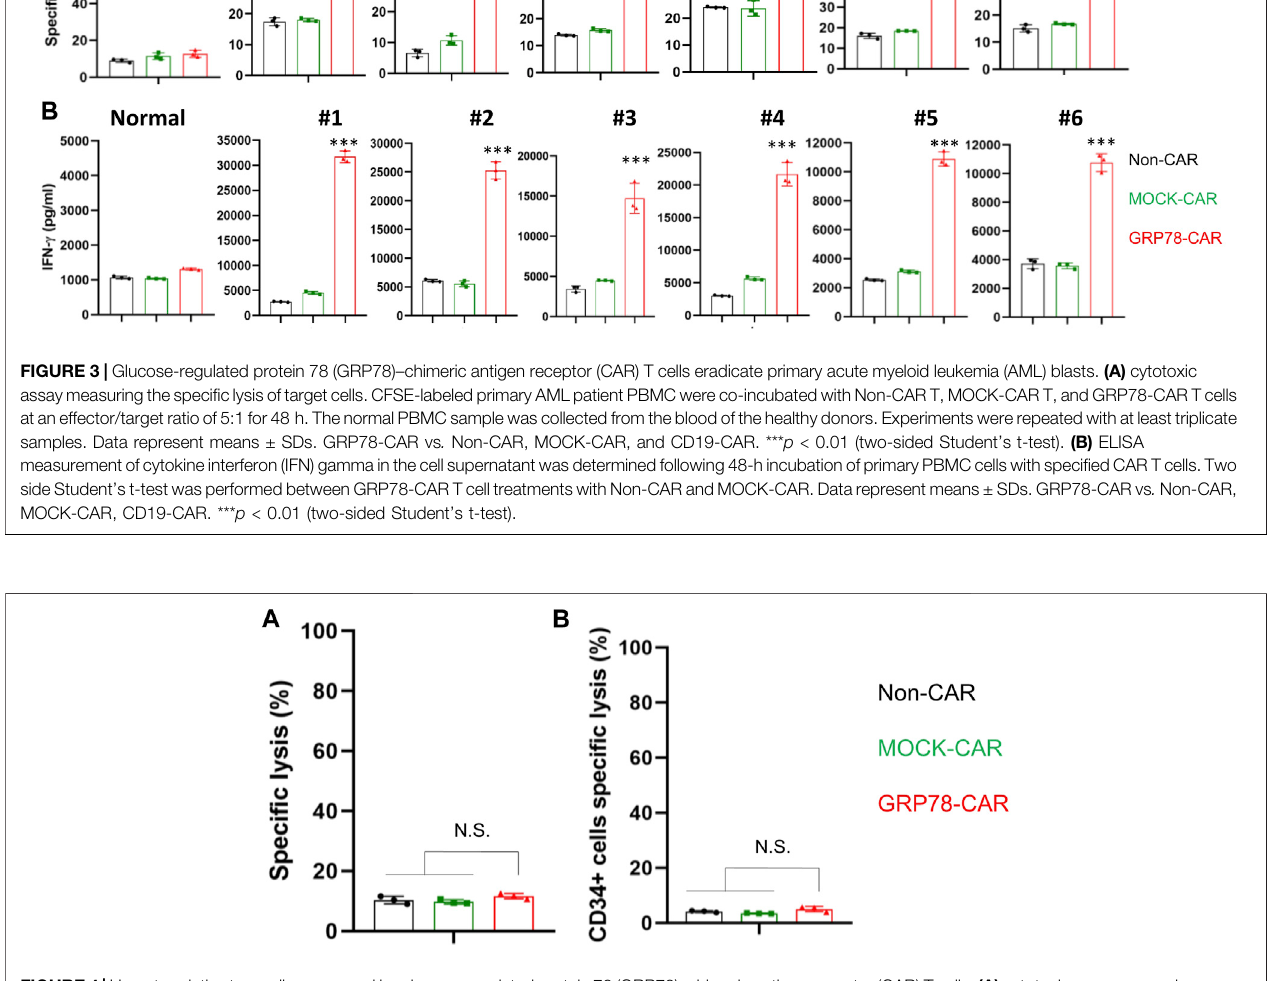
Frontiers in Cell and Developmental Biology |